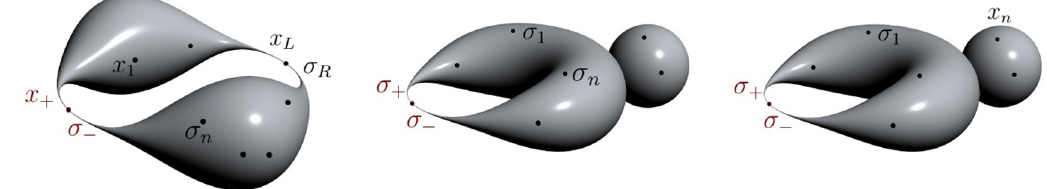
Figure 9 . All singular worldsheet con(cid:12)gurations corresponding to physical poles. The geometry on the left gives a single cut, and the two geometries in the middle and on the right correspond to inverse soft channels. In the BCFW recursion, the middle term does not contribute since its pole is una(cid:11)ected by the